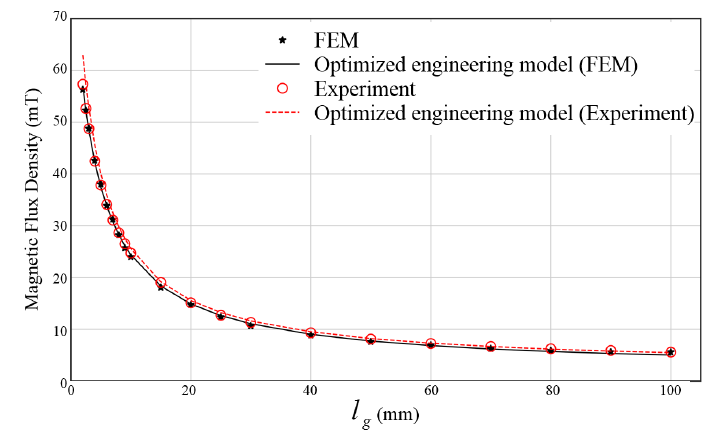
Figure 4. The measured and simulated mean magnetic flux density with their optimized engineering models on whole cross-section of the U-shaped